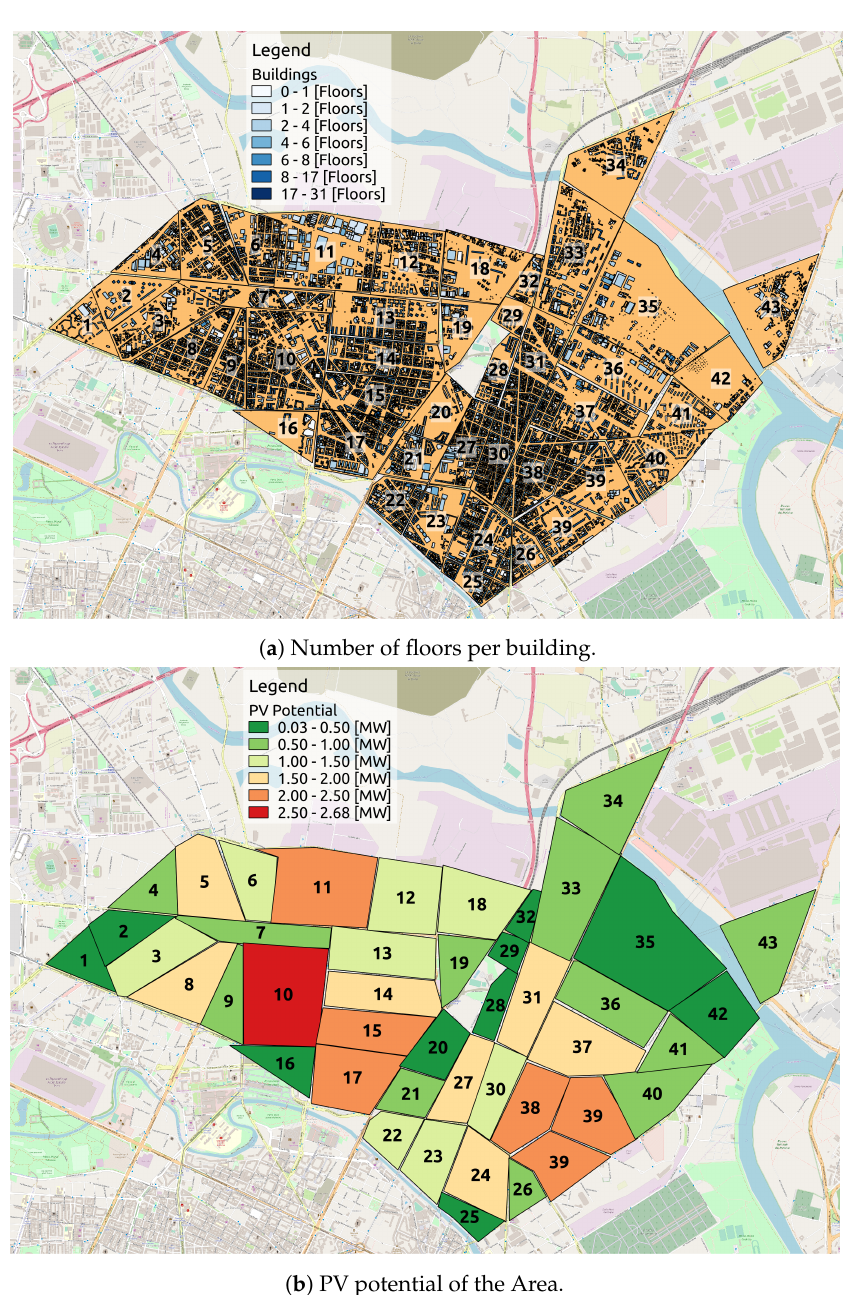
Figure 8. Case study